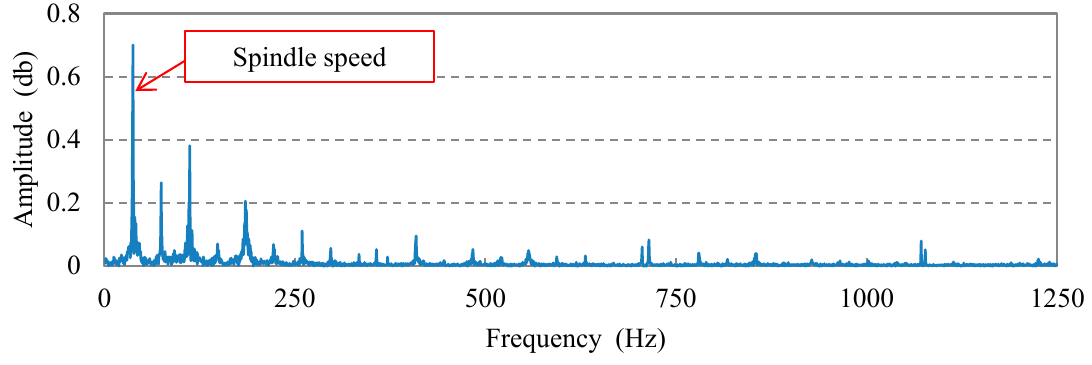
Figure 7. Bending moment spectrum under cutting (spindle speed: 2238 rpm).